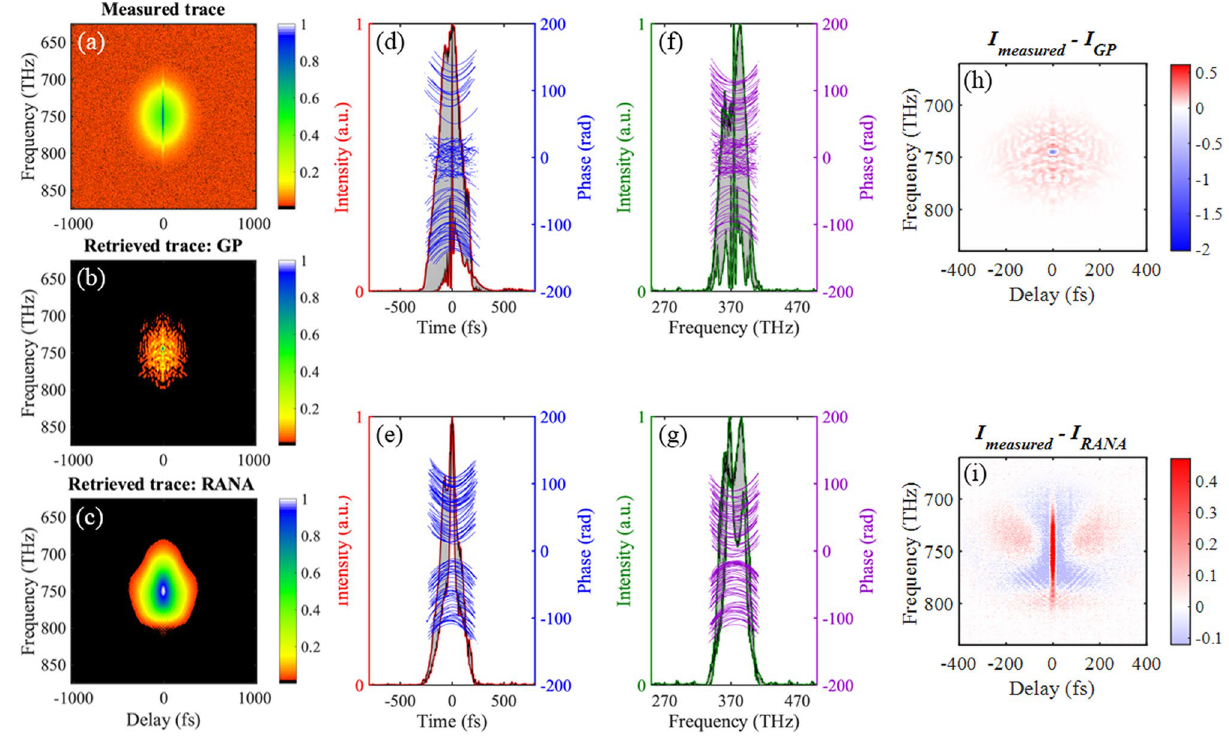
Figure 5. ( a ) The noisy trace corresponding to the train of pulses with an average temporal FWHM of 108 fs. Note the narrow coherent artifact for near-zero delays. ( b ) The reconstructed trace obtained using the GP algorithm for which the G ′ error has the highest value (that is, the worst-case retrieval). ( c ) The analogous worst- case retrieved trace obtained using the RANA approach. The retrieved temporal and spectral intensities of the results corresponding to curves with maximum and minimum FWHMs and all the retrieved phases for GP ( d , f ) and the RANA approach ( e , g ) are shown. The phase curves grouped in the center of ( d ) and ( f ) correspond to the stagnated results, and the two other groups, with positive and negative chirps, are the retrieval results with the direction of time ambiguity inherent to SHG FROG, and correspond to results converged to the smallest achievable G ′ errors. ( f ) The reconstructed trace obtained using the GP algorithm for which the G ′ error has the highest value (that is, the worst-case retrieval). ( g ) The analogous worst-case retrieved trace obtained using the RANA approach. ( h , and i ) The discrepancy between the measured and retrieved traces for the RANA approach is entirely indicative of instability, whereas that for GP is partially due to